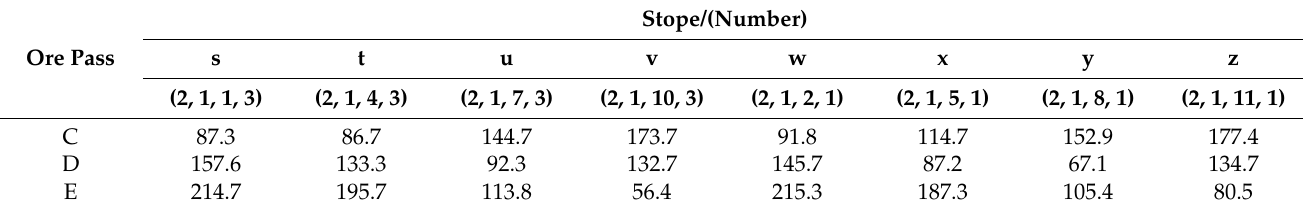
Table 4. Loaded travel time of the scraper between the stope and ore pass in ( 2, 1 ) sublevel/s (Units: s).